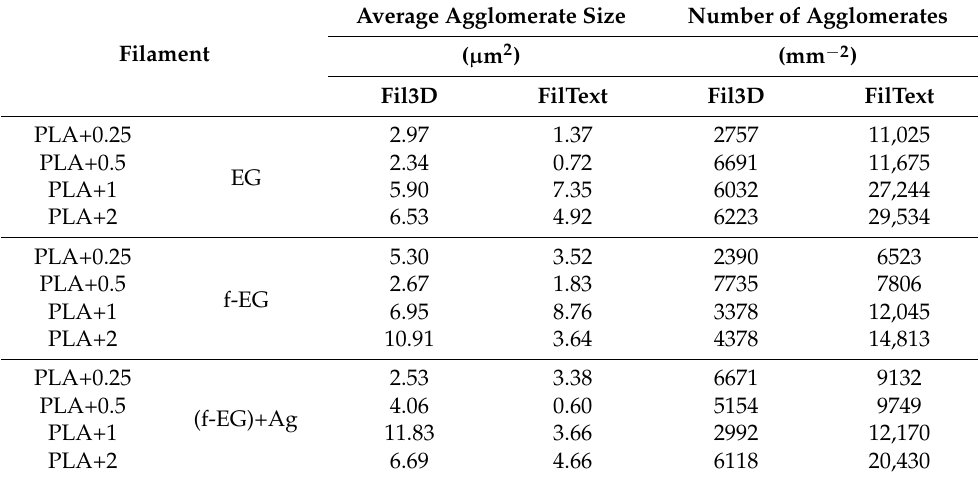
Table 2. Characterization of Fil3D and FilText’s cross-section by optical